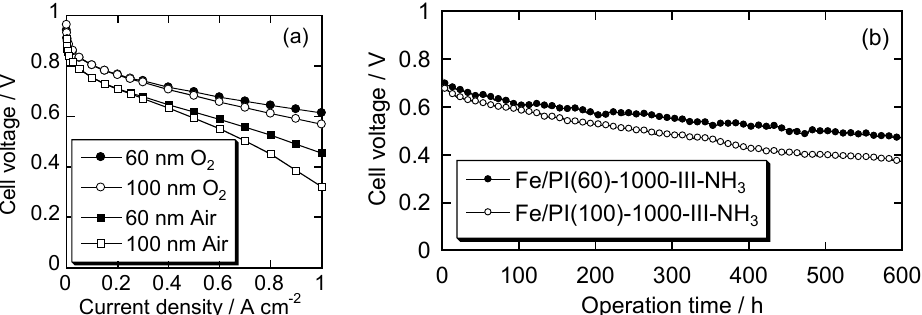
Figure 10. ( a ) I–V polarization curves under 0.2 MPa of total pressure with the Fe(2.0)/PI(100) and Fe(2.0)/PI(60) catalysts and ( b ) cell voltage stability curves under 0.2 MPa of air at 0.2 A cm −2 . Anode: PtRu/C catalyst with 0.4 mg-PtRu cm −2 loading, humidified H 2 at 80 °C. Cathode: 4 mg cm −2 catalyst loading, pure or balanced O 2 (humidified) at 80 °C. Electrolyte: Nafion NR211. T = 80 °C [45].